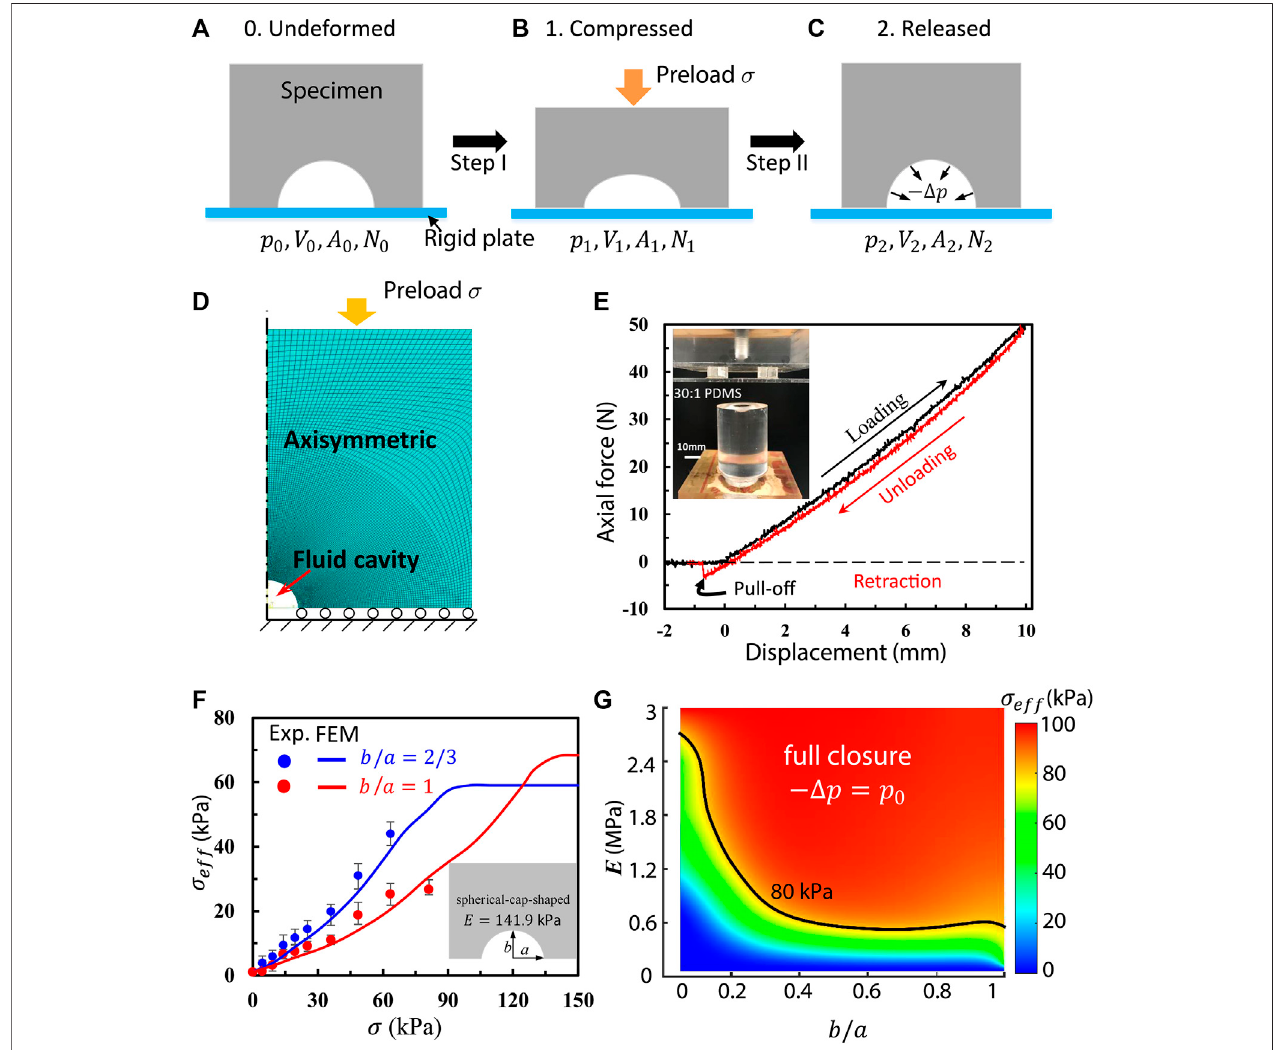
FIGURE 6 | The model of a macroscopic, isolated crater in air. (A – C) Schematics of the loading-unloading process that generates suction. (D) An axisymmetric fi nite element model (FEM) for simulating isolated craters. (E) A representative loading-unloading-retraction curve for a cratered specimen. The inset shows the experimentalsetup. (F) Effective adhesive strength asafunctionofthepreload forspherical-cap-shaped (SCS) craterswithaspectratios b / a (cid:3) 2 / 3and 1. (G) Acontour plotforeffectiveadhesivestrength σ eff asafunctionofthematrixYoung ’ smodulus E andcrateraspectratio b / a .[reprintedwithpermissionfrom(Qiaoetal.,2017)]